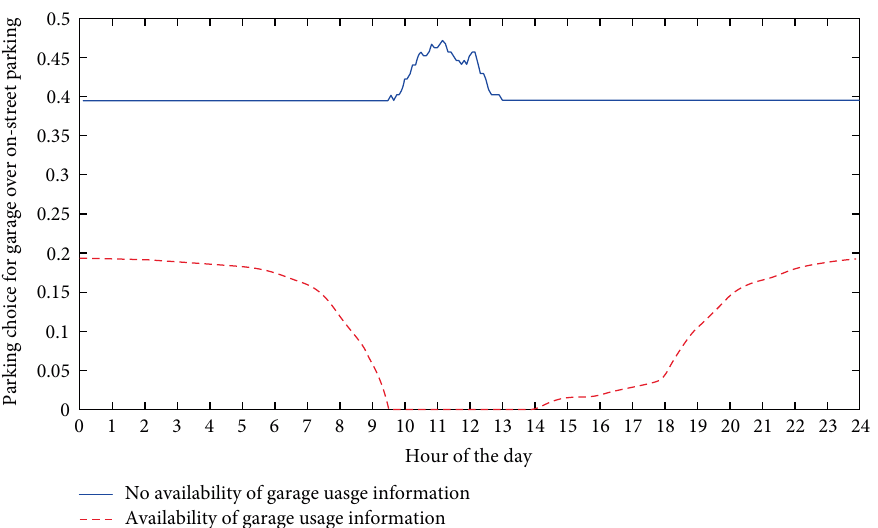
Figure 11: Parking choice for garage over on-street parking over a typical working day. The parking choice is illustrated for the scenarios without (Section 4.3) and with (Section 4.5) available garage usage information for all drivers. This choice is only possible for drivers with . desired parking duration 𝑡 𝑑 ≤ 𝜏 𝑜𝑝